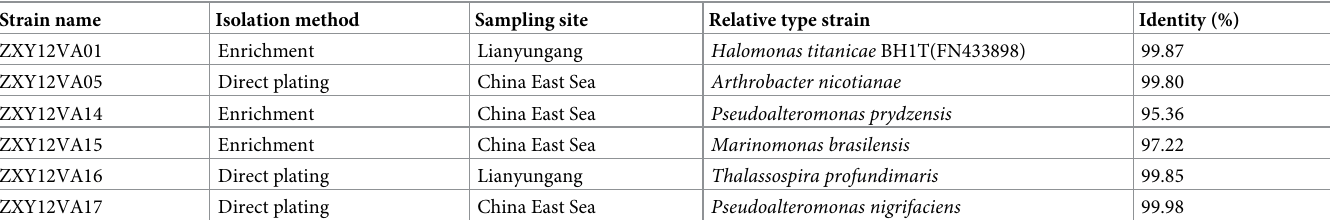
Table 1. Strains isolated in this